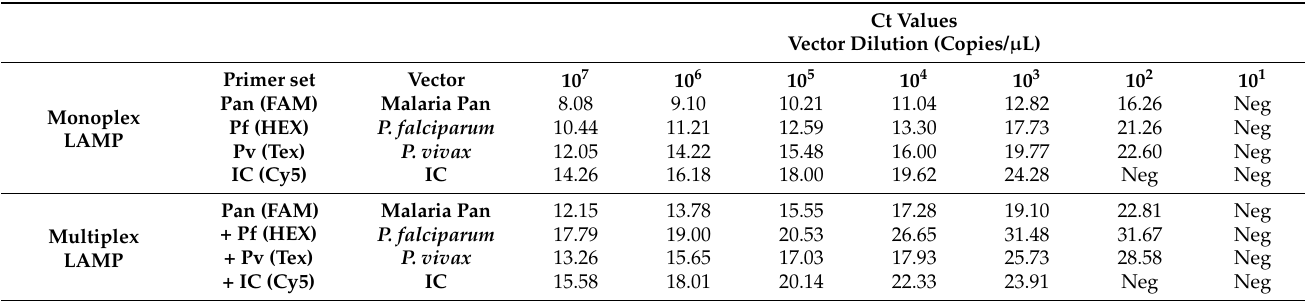
Figure 2. Limit of detection (LOD) test for the monoplex and multiplex malaria Pan/Pf/Pv/IC LAMP primer set. ( A ) The monoplex malaria Pan, Plasmodium falciparum , Plasmodium vivax , and IC LAMP primer sets (left, middle, and right panels, respectively). ( B ) Multiplex malaria Pan/Pf/Pv/IC LAMP primer set, respectively. The monoplex and multiplex malaria Pan/Pf/Pv/IC LAMP assays were performed with synthetic malaria Pan, P. falciparum , P. vivax , or beta-actin vectors, ranging from 10 7 to 10 1 RNA copies/ µ L. Colors (red, orange, green, blue, purple, pink, black, and olive) indicate vector copy numbers/ µ L (1.0 × 10 7 to 1.0 × 10 1 copies/ µ L) and distilled water (DW; negative control). The LOD test was performed in duplicate. IC, internal control; LAMP, loop-mediated isothermal amplification. Table 2. Limit of detection (LOD) tests of monoplex and multiplex malaria Pan/Pf/Pv/IC LAMP assay for malaria Pan, Plasmodium falciparum , Plasmodium vivax , and internal control vectors (range: 10 7 –10 1